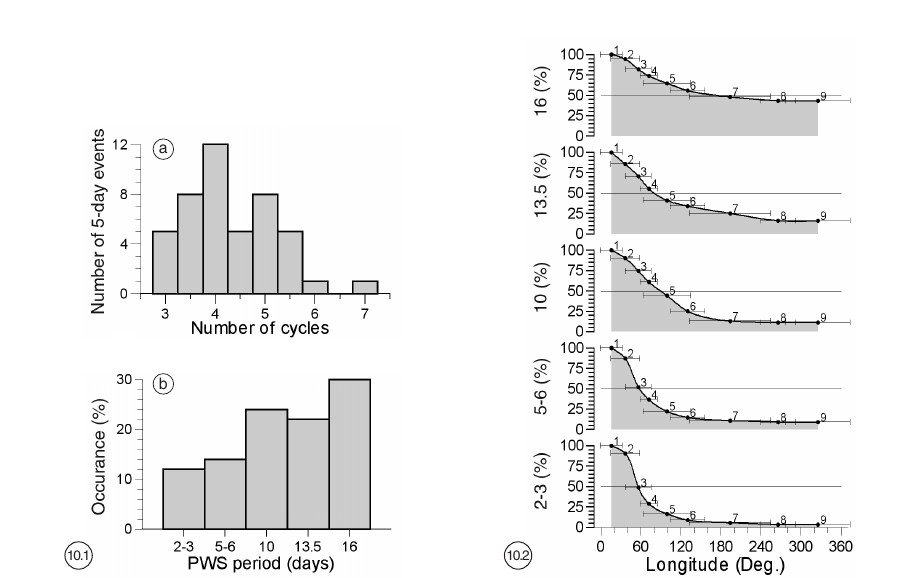
Fig. 10.1a,b. The top plot shows an example of the typical duration of PWS in terms of number of cycles for the 5-day events (after Las ˇ tovic ˇ ka et al., 2003a). The bottom plot depicts the typical percentage of occurrence of PWS events according to their dominant oscillating periods (after Altadill and Apostolov, 2003). Fig. 10.2. The plots shows the percentage of occurrence of PWS events ( y axes) referred to the number events found to exist in sector 1 as function of their longitudinal size ( x axis). The horizontal error bars mean the lon- gitudinal size of the labeled midlatitude sector. The horizontal lines of each plot indicate the assumed threshold for the typical longitudinal size (after Altadill and Apostolov, 2003).